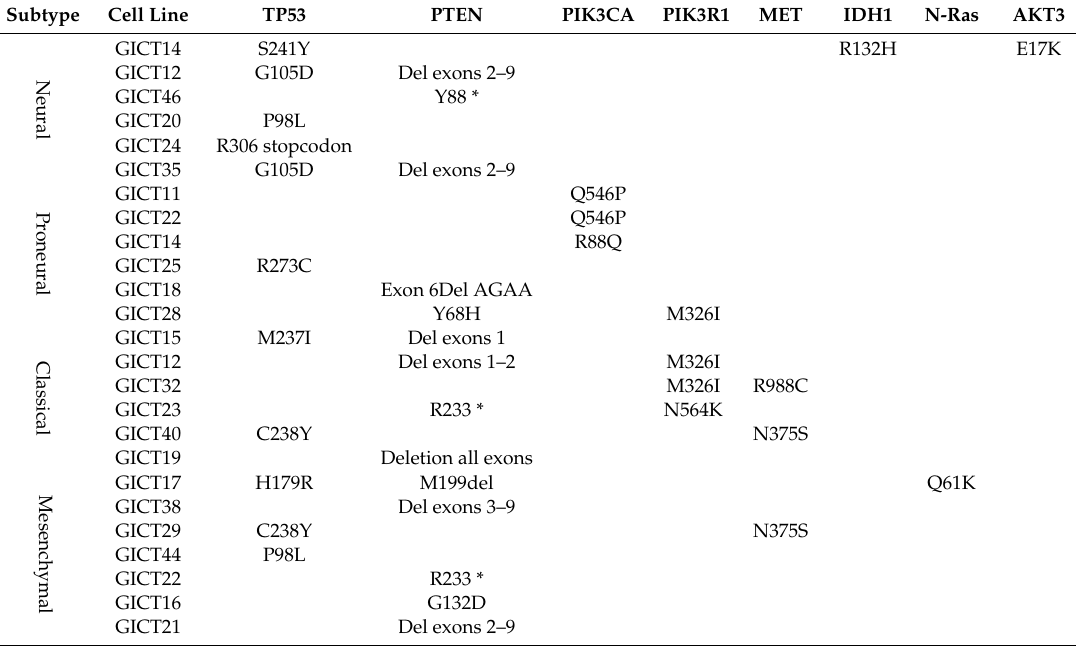
Table 1. Mutation analysis in